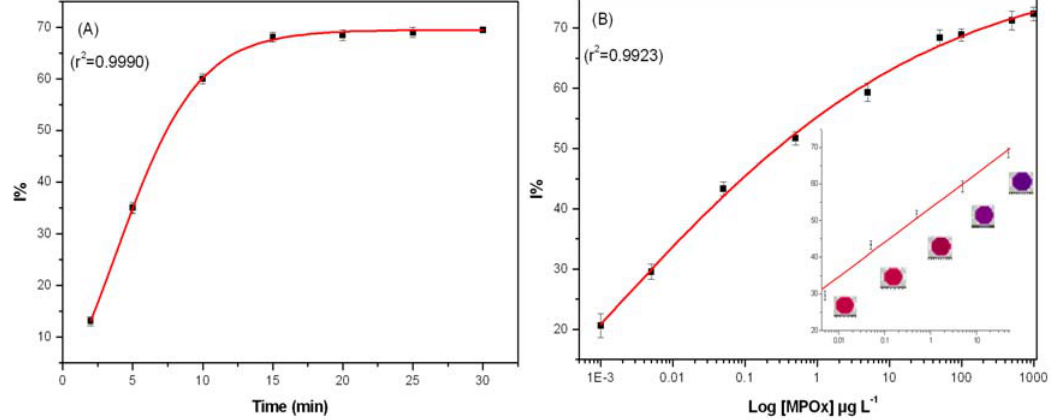
Figure 3 . (A) Inhibition profile obtained for 50 µg·L − 1 MPOx at different incubation time using 0.5 mM BuChCl at 30 °C; (B) Calibration curve obtained for MPOx in PB using 0.08 U BuChE with 0.5 mM BuChCl, 0.004 U ChOx, 0.0008 U HRP, 0.1 M PB, pH 7.4 at 30 °C. ( Inset: linear range for MPOx with CL image )